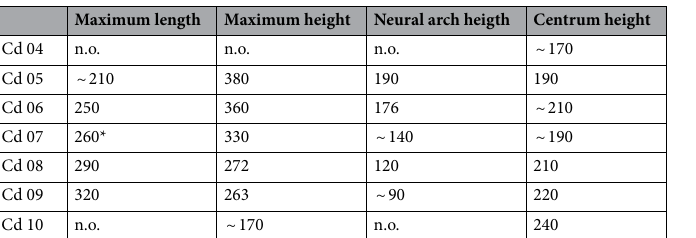
Table 2. Selected measurements of Hamititan xinjiangensis gen. et sp. nov. (in mm). “ ~ ” indicates approximate measurements; “*” indicates bones not fully exposed. n.o., not observable.